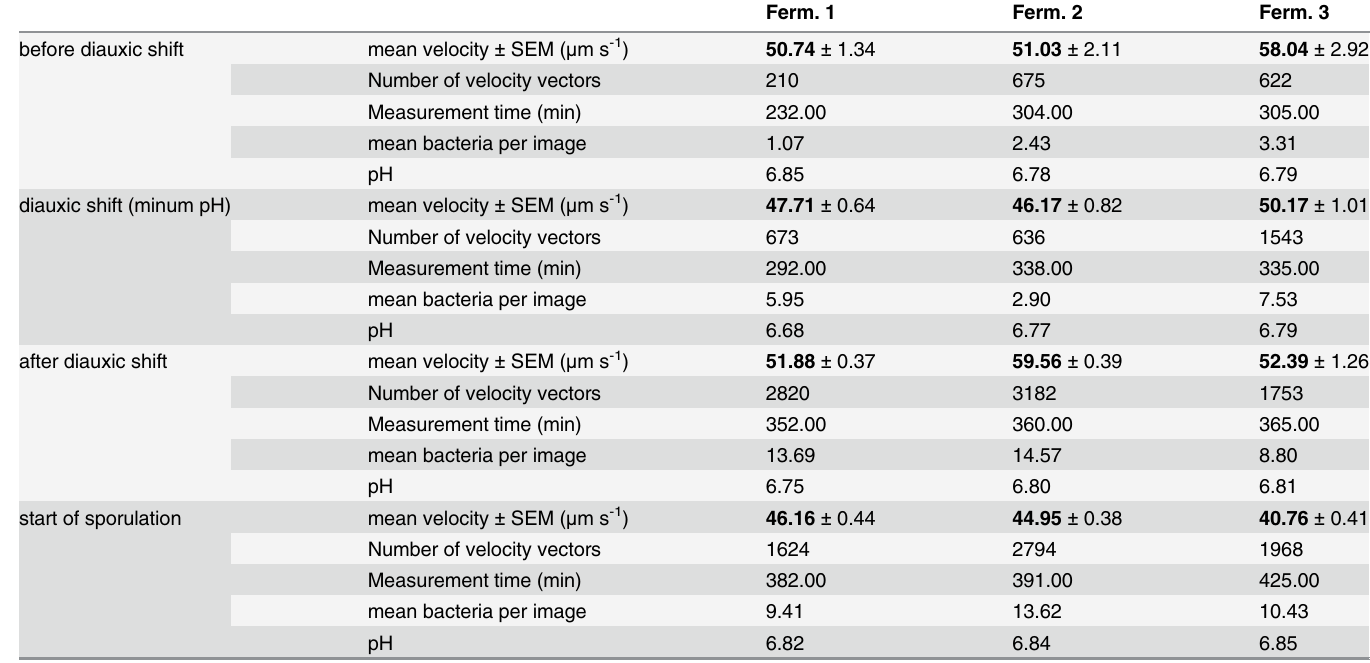
Table 2. Summary of the specific stages of the three monitored